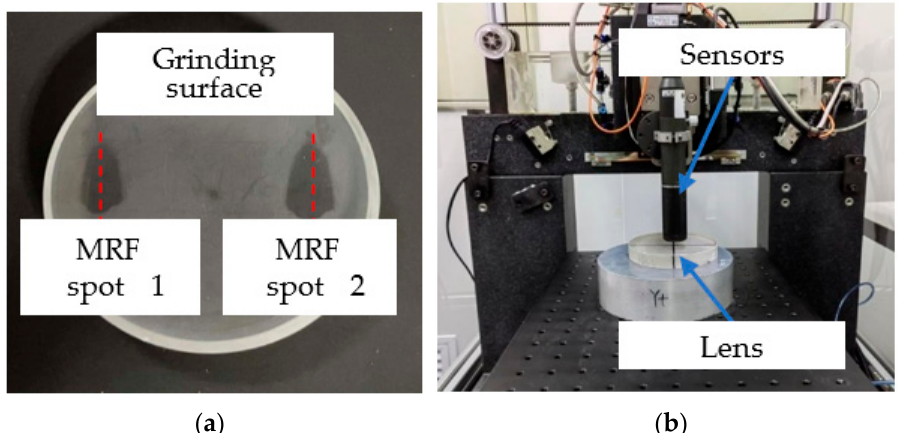
Figure 17. Measurement of subsurface cracks after grinding using a magnetorheological spot method. ( a ) MRF spots on the surface of samples after HF Shallow etching. ( b ) Measuring spot cen ‐ terline using a three ‐ dimensional profiler.